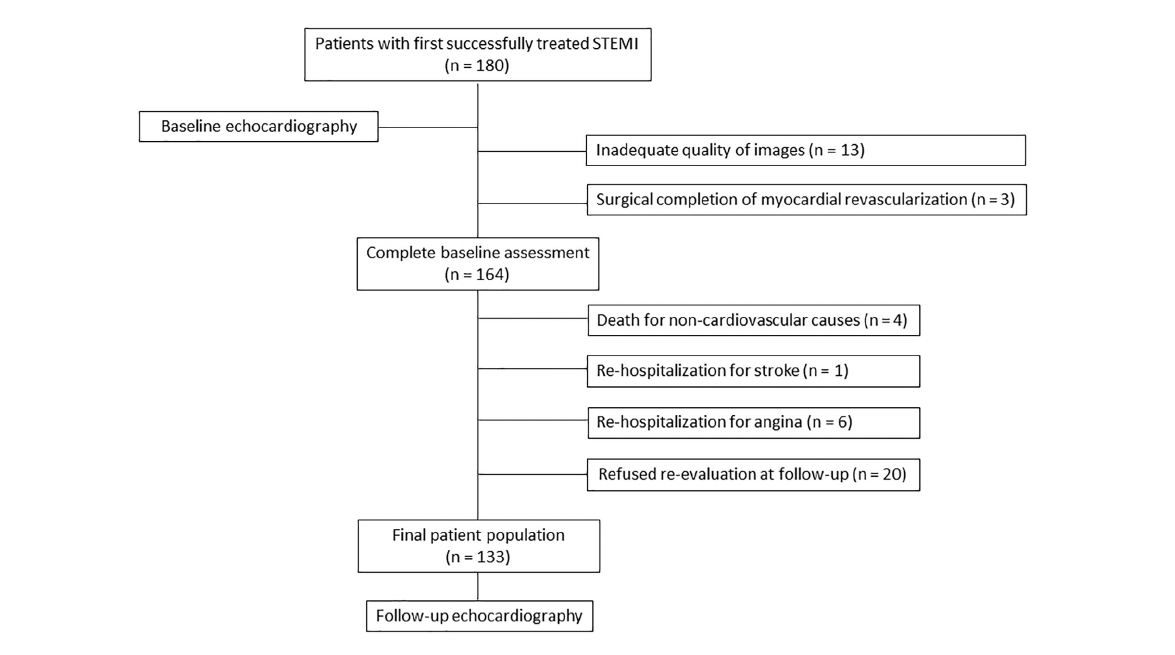
FIGURE1 Study flow-chart. STEMI, ST-segment elevation myocardial